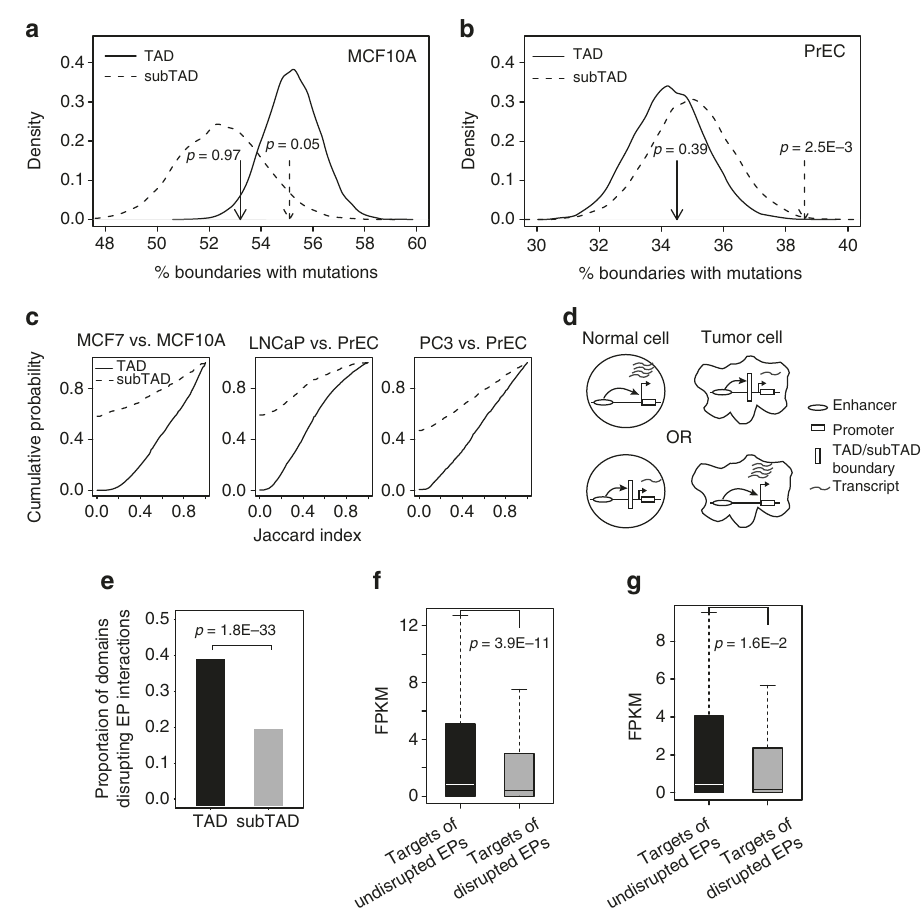
Fig. 5 Relationship between hierarchical domain boundary, somatic mutation, and enhancer – promoter communication . a , b SubTAD but not TAD boundaries are enriched for somatic mutations in cancer. Percentage of TAD and subTAD boundaries overlapping with at least one recurrent mutations for MCF10A cells a and PrEC cells b . TAD and subTADs were identi fi ed using Hi-C data for non-tumorigenic mammary gland epithelial cell line (MCF10A) and prostate epithelial cell line (PrEC). Solid line , TADs; Dashed line : subTADs. Observed percentages are indicated by vertical lines with an arrow . Distributions of expected percentages are generated using 10,000 sets of randomly selected genomic regions with the same number and size as the called TADs/subTADs for each cancer cell type. c SubTAD boundaries are more dynamics than TAD boundaries between cancer and normal cells. MCF7, breast adenocarcinoma cell line; LNCaP, prostate carcinoma cell line; PC3, prostate adenocarcinoma cell line. d Schematic demonstrating that cell-type-speci fi c enhancer – promoter ( EP ) interactions are blocked by newly formed domain boundary in the other cell type. e Proportion of cell-type-speci fi c domain boundaries that overlap with cell-type-speci fi c EP interactions in the other cell type. P -value is based on t -test. f Expression levels of promoters involved in cell-speci fi c EP interactions that are blocked by TAD boundary in the other cell type. g Expression levels of promoters involved in cell-speci fi c EP interactions that are blocked by subTAD boundary in the other cell type. P -values are based on t -test. The whiskers represent the most extreme data point which is no more than 1.5 times the interquartile